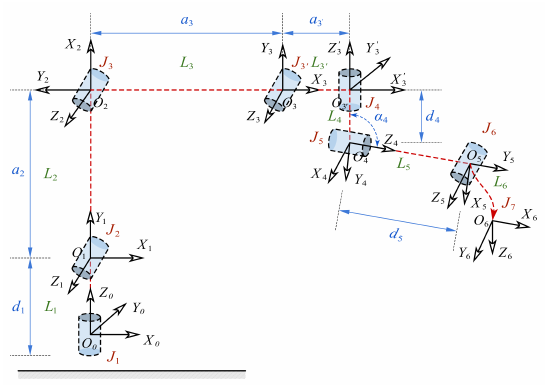
Figure 3. D-H coordinate system of the puncture